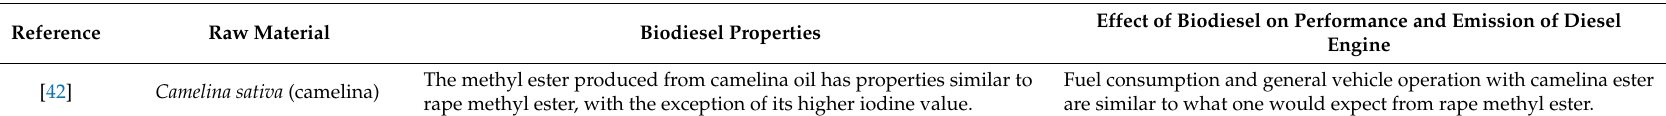
Table 1. A number of studies about biodiesel of different cultivar of camelina